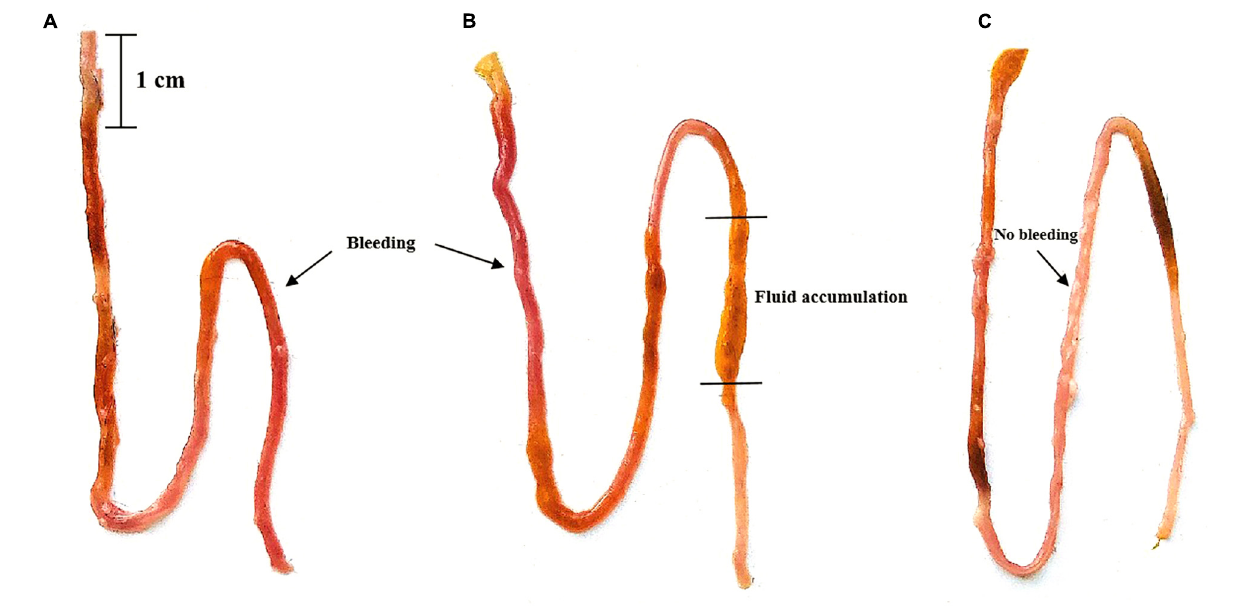
Inflammation is the body’s response to infection. The